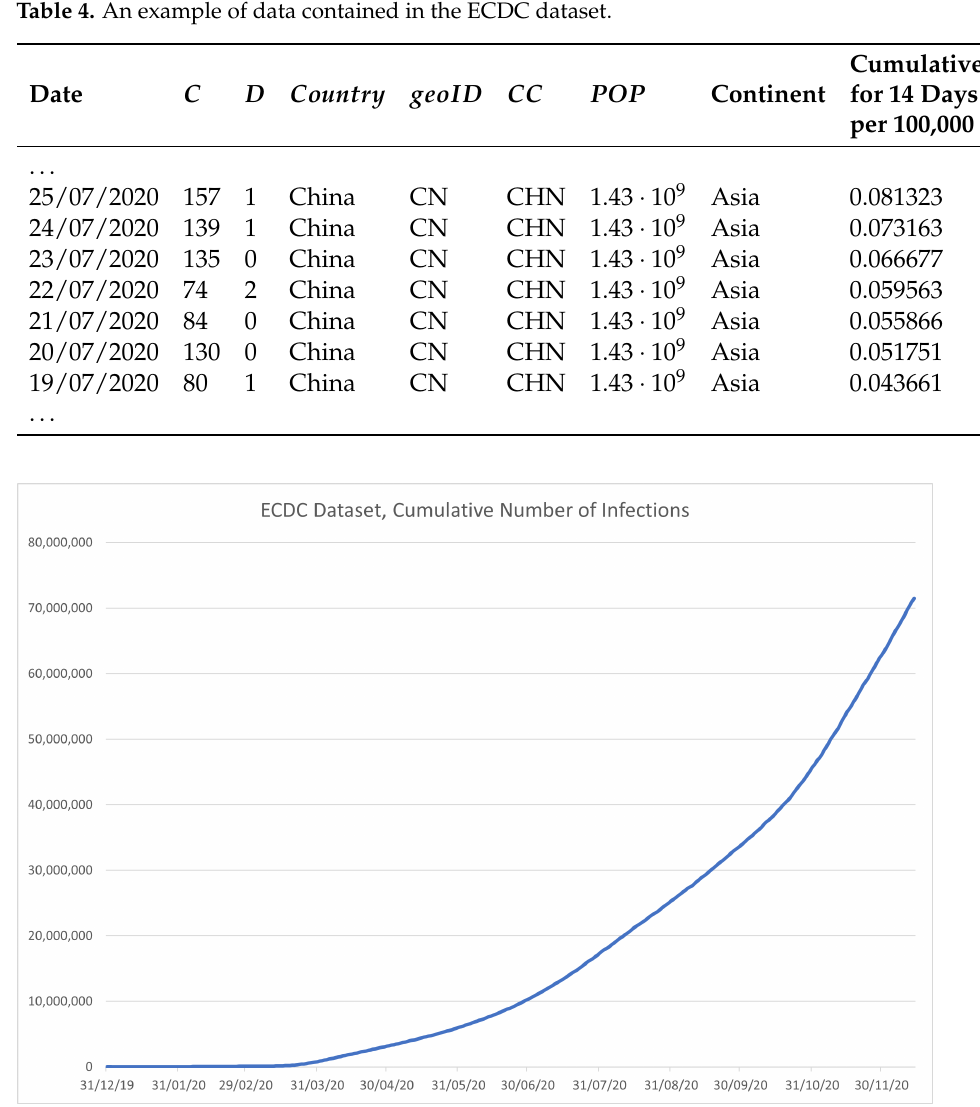
Table 4. An example of data contained in the ECDC dataset.